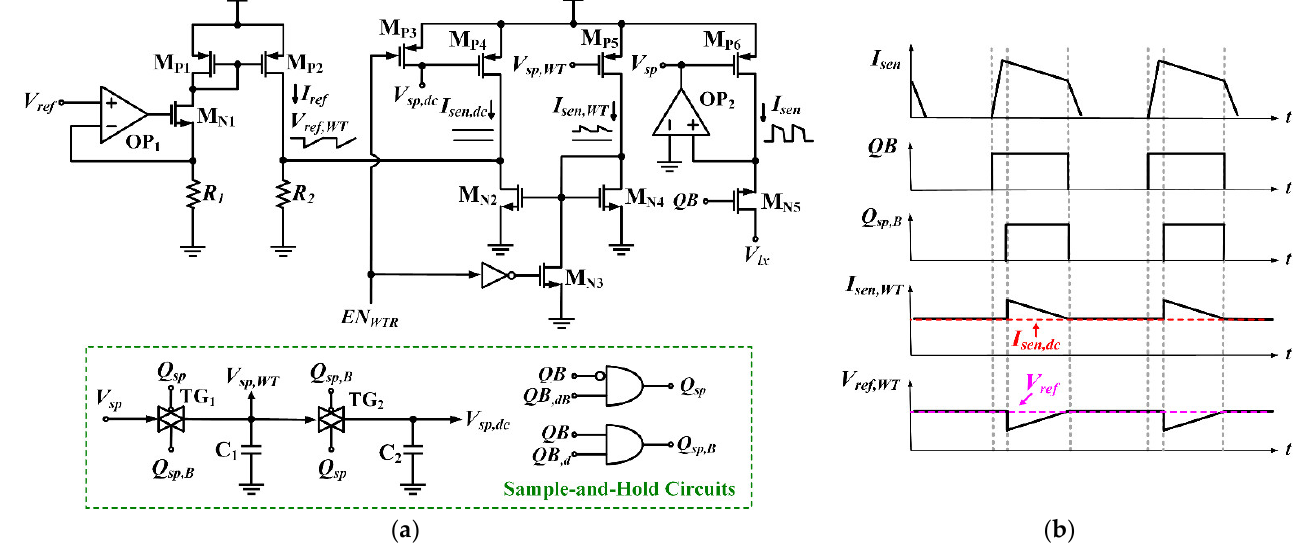
Figure 7. ( a ) Schematic and ( b ) operation waveforms of the tracking reference